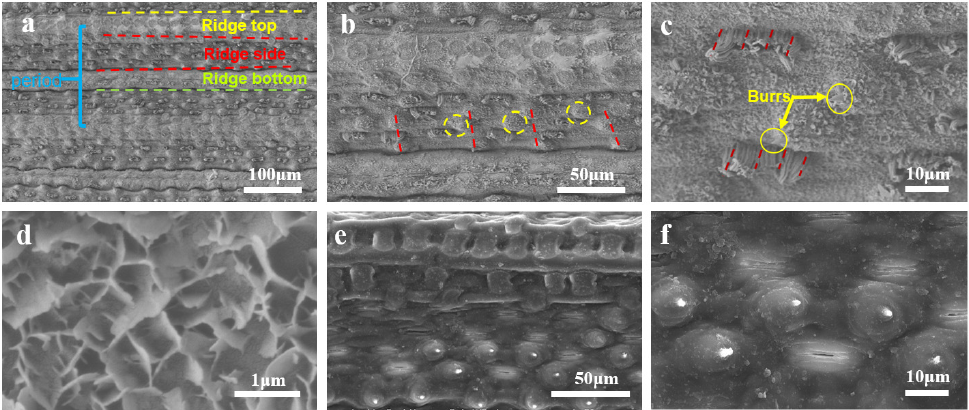
Figure 3. SEM photographs of the PCL surface. ( a ) The periodic sub-millimetre ridge structure; ( b , c ) the micron-scale structures on the top, side and bottom of the ridge structure; ( d ) the nanoscale sheet structure covering the PCL surface; ( e , f ) PCL surface morphology after cooking in boiling water.